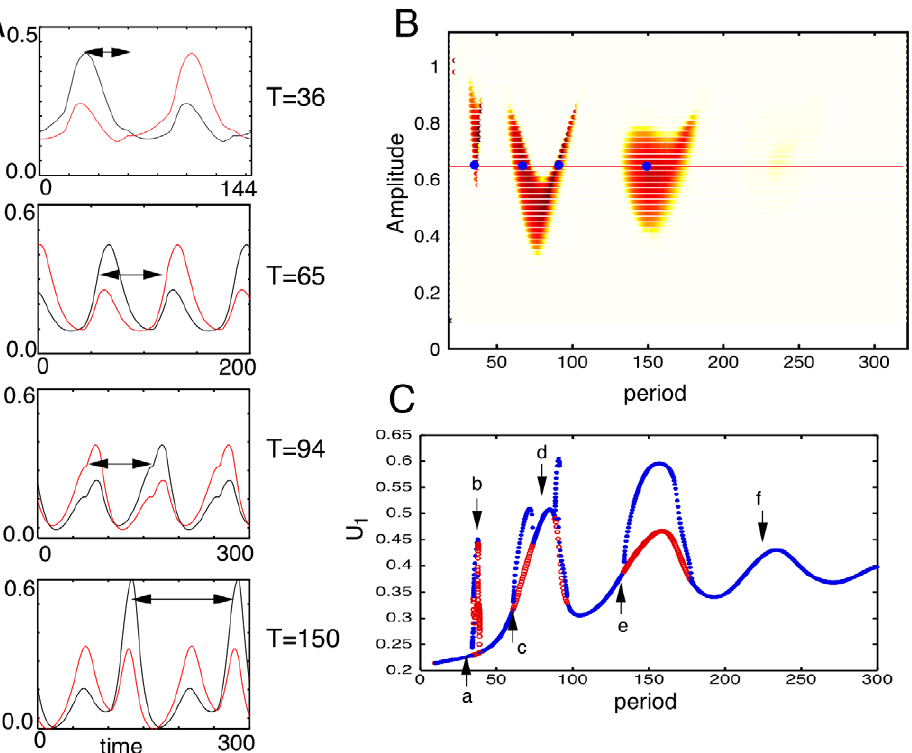
Figure 7. Global picture for the simple 4-dimensional model. (A) Plots of U 1 , U 2 for different periods of forcing with an amplitude of 0.65. (B) Phase diagram as the amplitude and period of the forcing vary; color code is the ‘‘depth’’ of the pattern (the difference between U 1 and U 2 ) with dark red/black the deepest. (Blue dots correspond to the four periods shown in A.) (C) Bifurcation diagram for A ~ 0 : 65 : Red curves are unstable periodic orbits and blue are stable. See text for details.